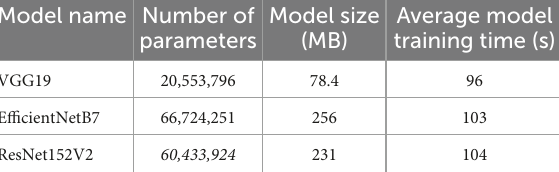
TABLE 2 Comparison of the three models.